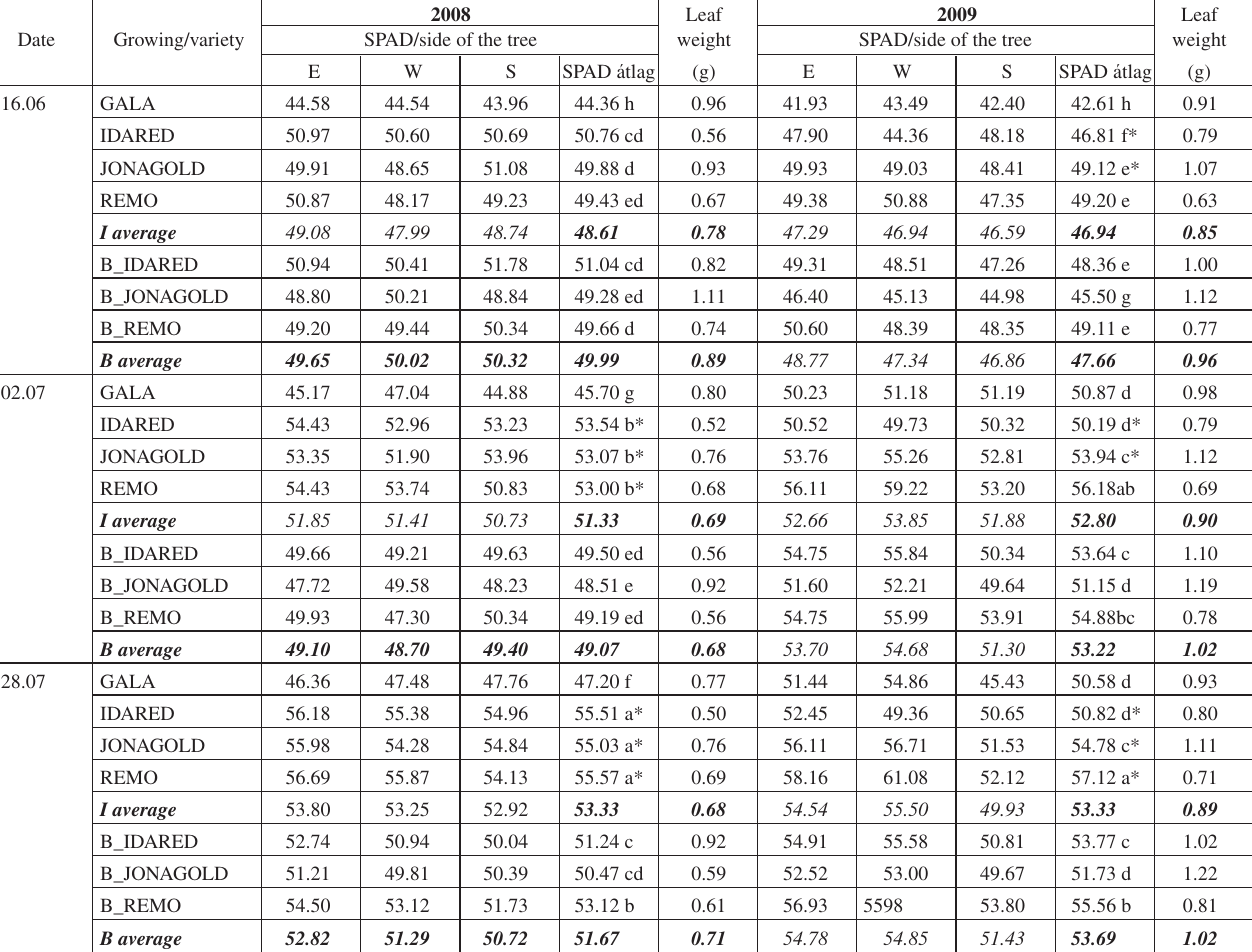
Table 3. Changes in the SPAD and leaf weight on different side of apple trees grown by integrated (I) and organic (B) technology (E= eastern side W=western side, S= southern side of the tree ) 2008